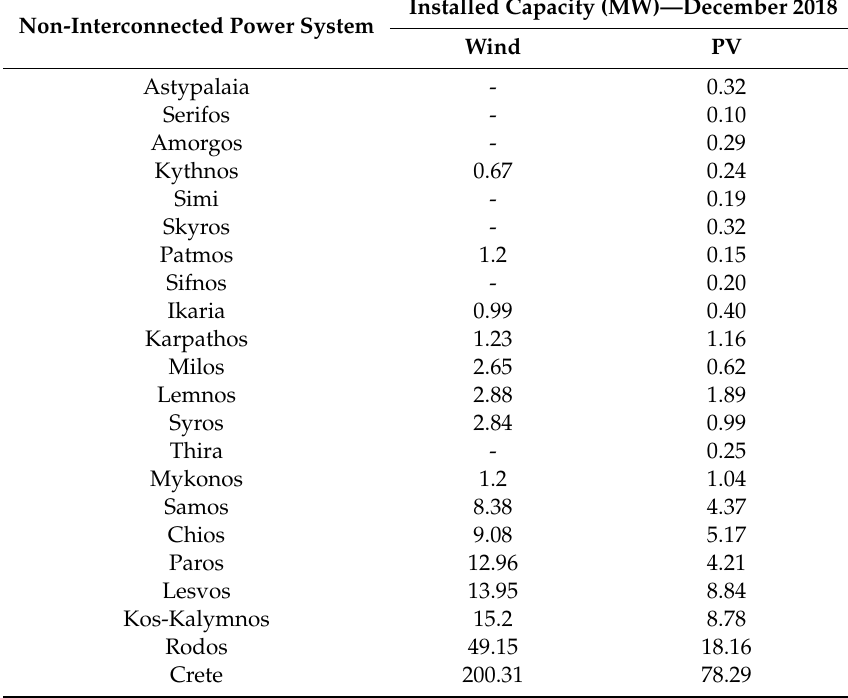
Table 5. Wind and PV installed capacity in non-interconnected Greek